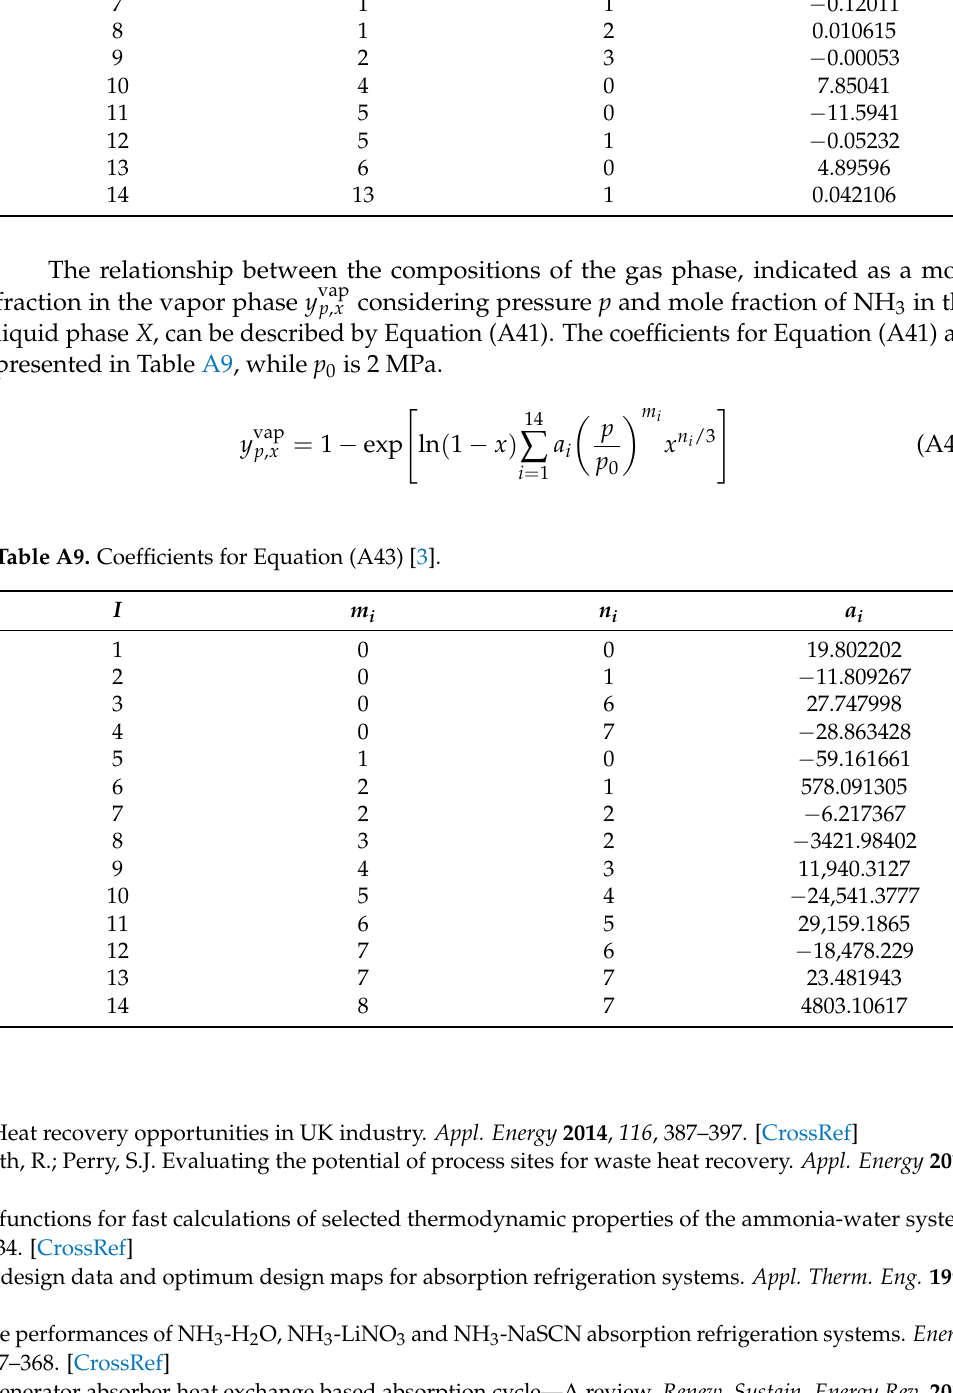
Table A8. Coefficients for Equation (A42) [3].